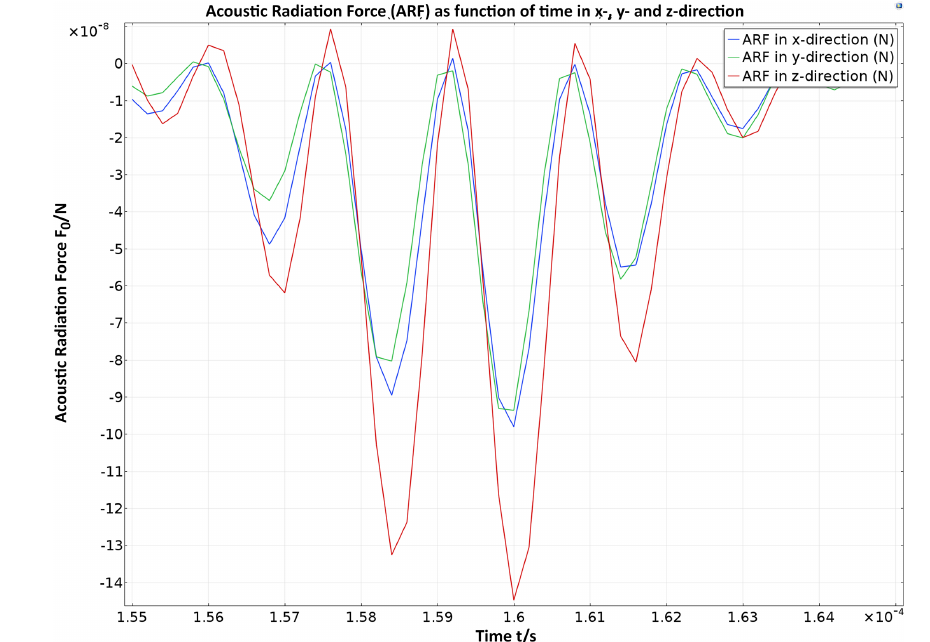
Figure 7. Time course of the resulting acoustic radiation force in x , y and z direction on an test particle of polystyrene with a diameter of 0.6mm. The particle is displaced 0.25mm outside the center of the particle trap, resulting in a continuous negative force effect. It ensures that the particle is shifted back to the center of the particle